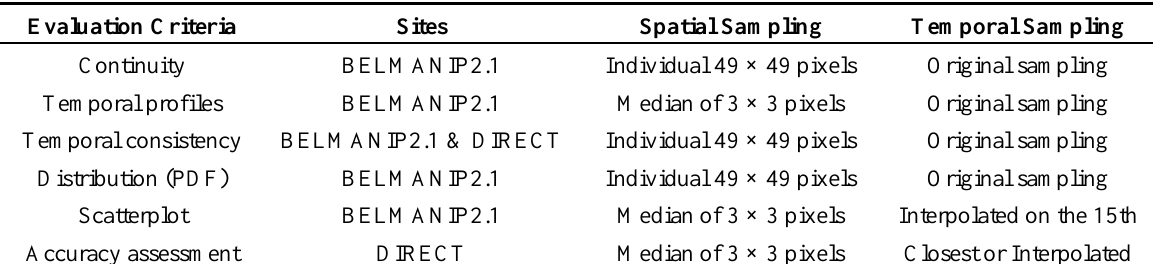
Table 3. Spatial and temporal sampling used for computing the metrics associated to each evaluation